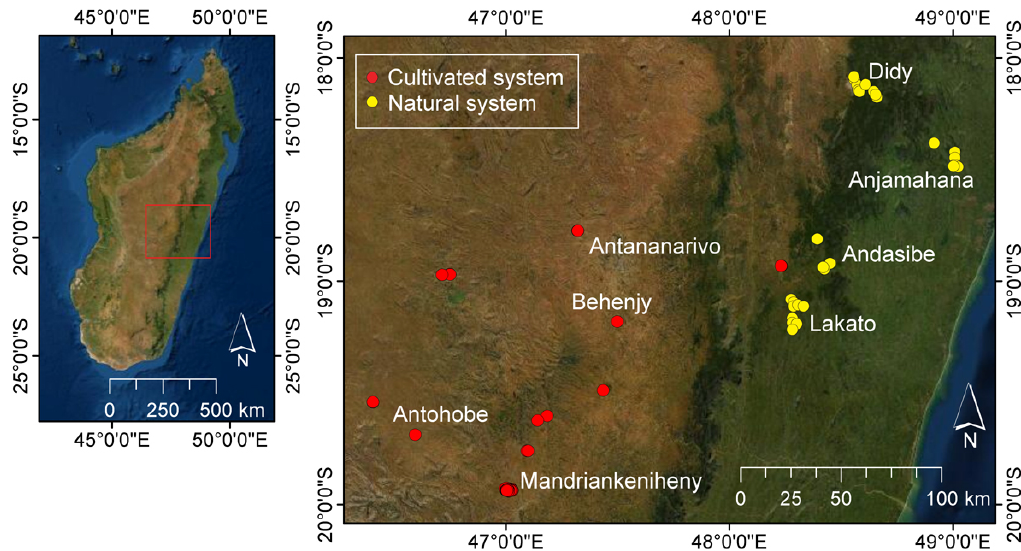
Figure 1. Studied regions and soil sampling points. Sources of background image: Esri, DigitalGlobe, GeoEye, Earthstar Geographics, CNES/Airbus DS, USDA, AeroGRID, IGN, and the GIS User Community.